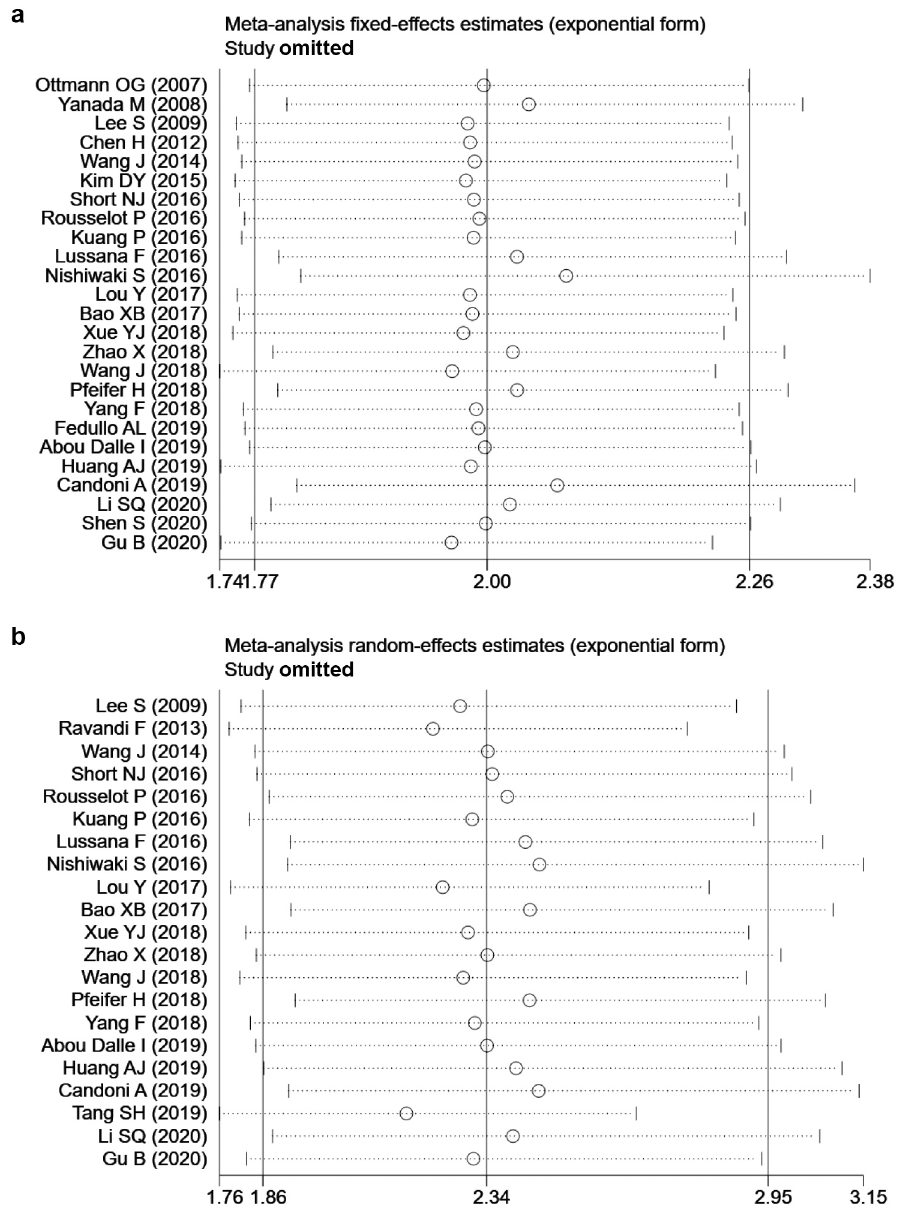
Fig 4. Sensitivity analysis for (a) event-free survival (EFS) and (b) overall survival